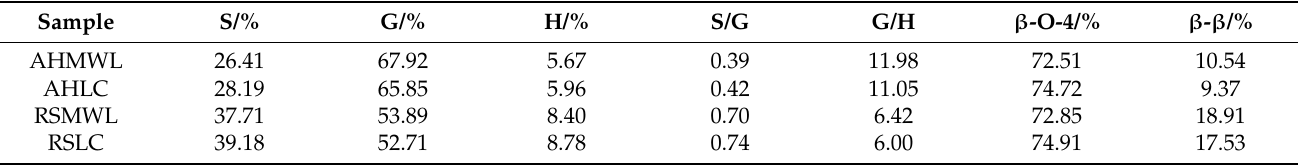
Table 7. The units and linkages proportion of MWL and LC.